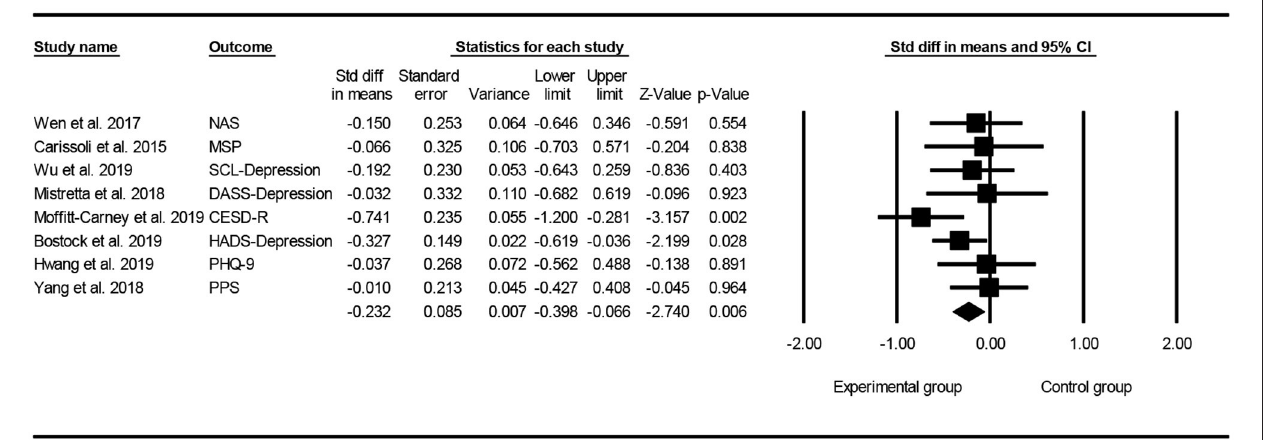
FIGURE 5 | Forest plot for negative